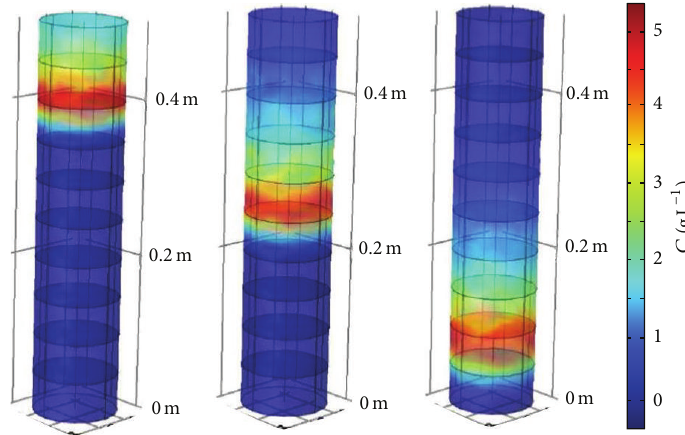
Figure 8: Simulation of a saline trace test in the column water flow by COMSOL Multiphysics.